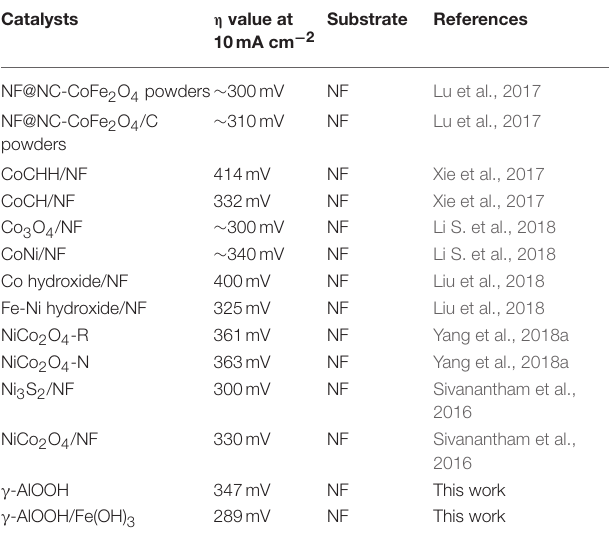
TABLE 1 | Summary of OER performances of different electrocatalysts.